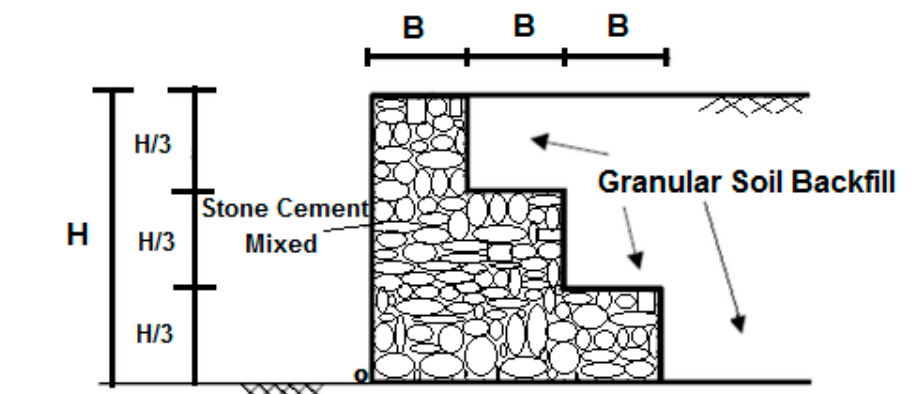
Figure 4. Dimension model for gravity masonry retaining wall.